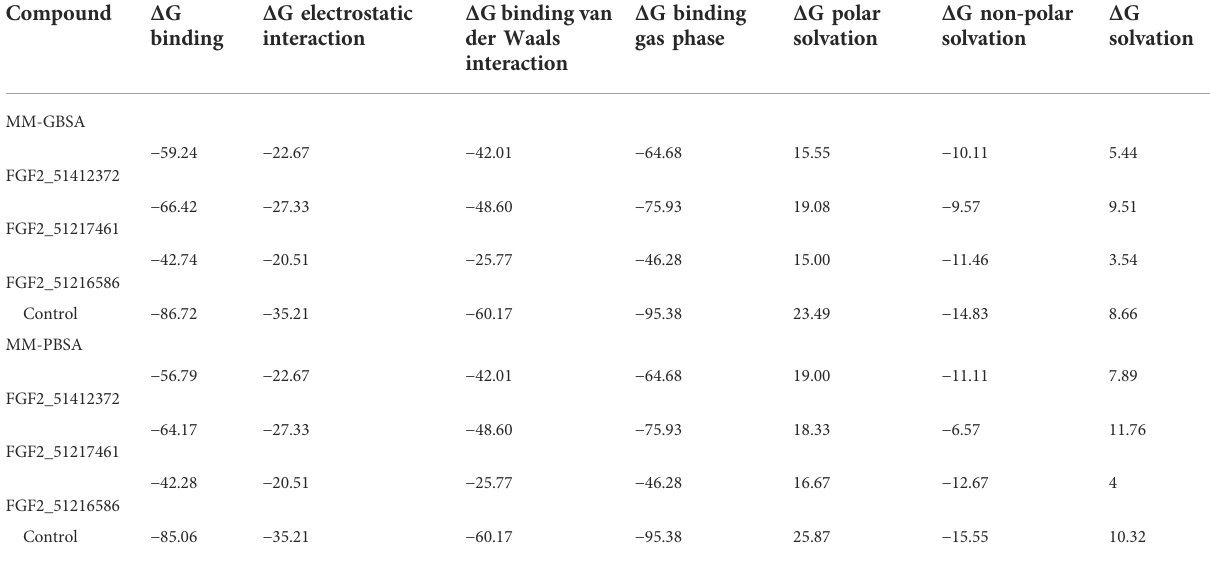
TABLE 1 Binding interaction energies estimated by two methods (MM-GBSA and MM-PBSA). The score against each parameter is given in kcal/mol. Compound